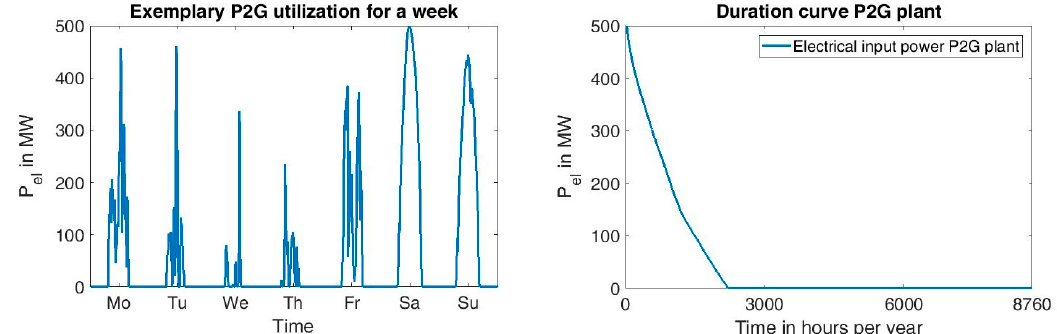
Figure 12. Exemplary electrical load flows of the power line Slack-1 in different scenarios.